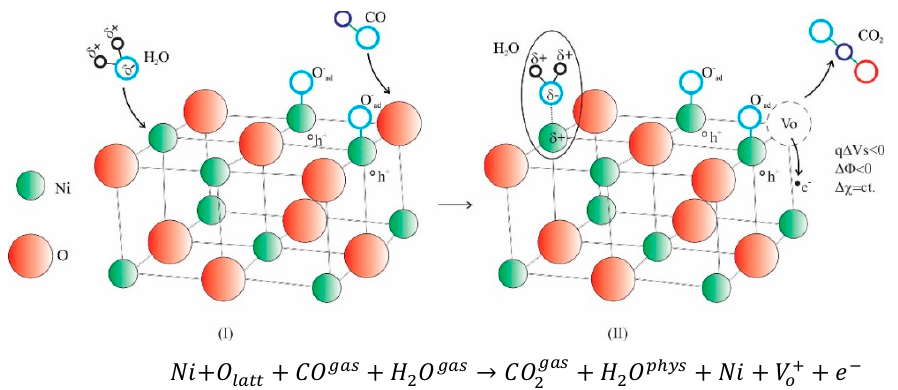
Figure 8. Cartoon revealing the interaction between CO and lattice oxygen for NiO-sensitive surface under RH background.